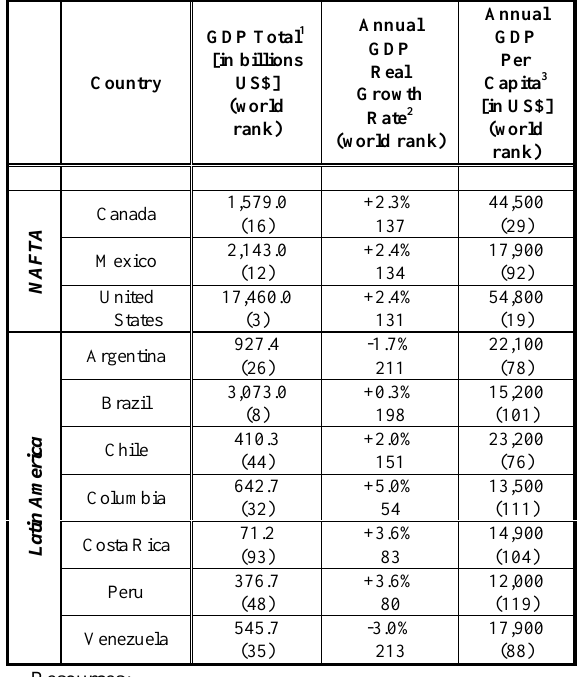
Table 2: GDP Total, Growth Rate and Per Capita by Country GDP Total Country